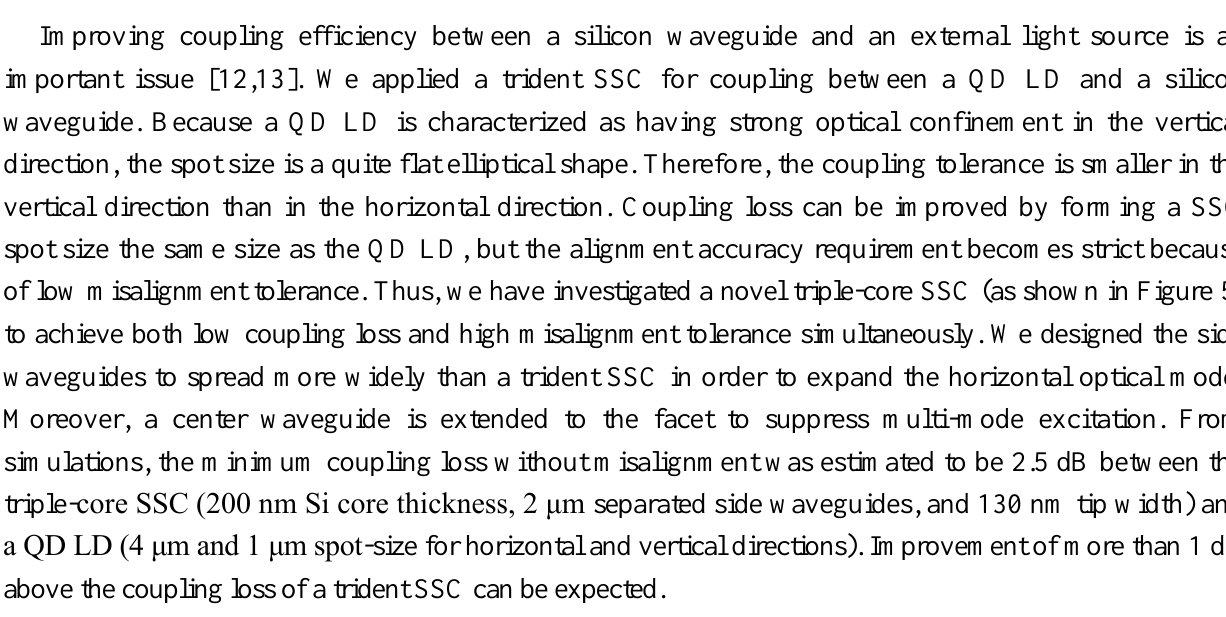
Figure 4. A hybrid integrated light source. ( a ) Schematic structure. ( b ) Light output characteristics. ( c ) Output power uniformity from each channel.